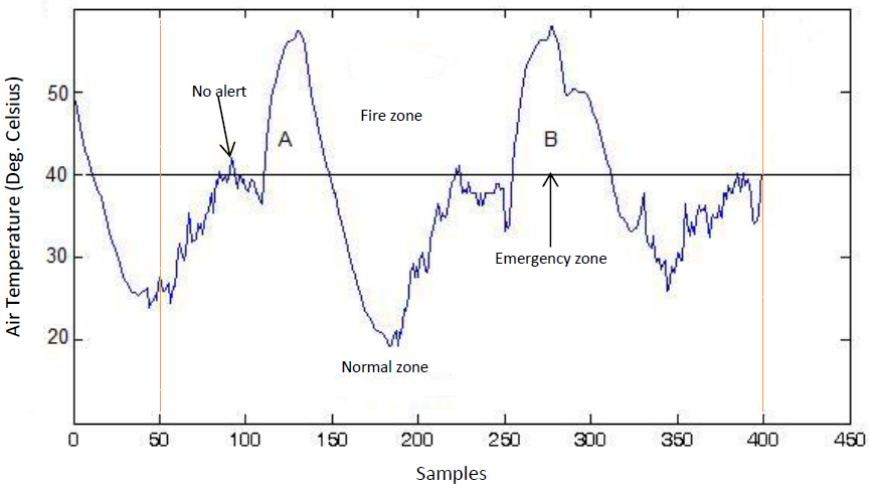
Figure 4. SWIFTNET: design